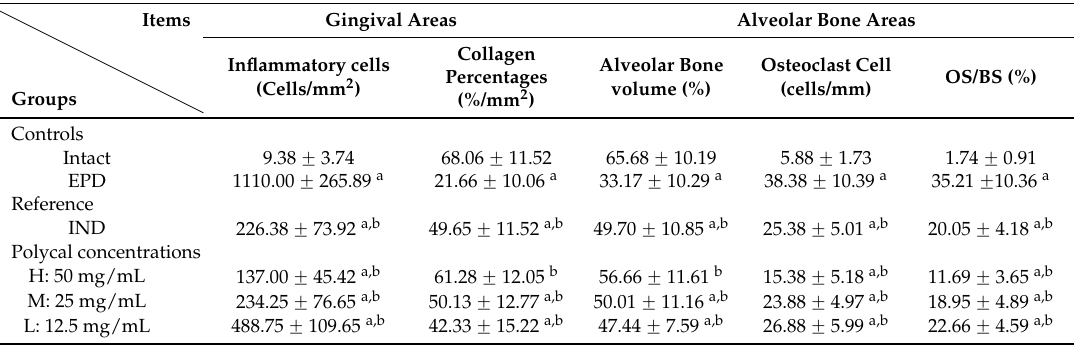
Table 2. Histomorphometrical analysis of maxillary regions around ligation placement—gingival and alveolar bone areas in Intact or EPD Rats.